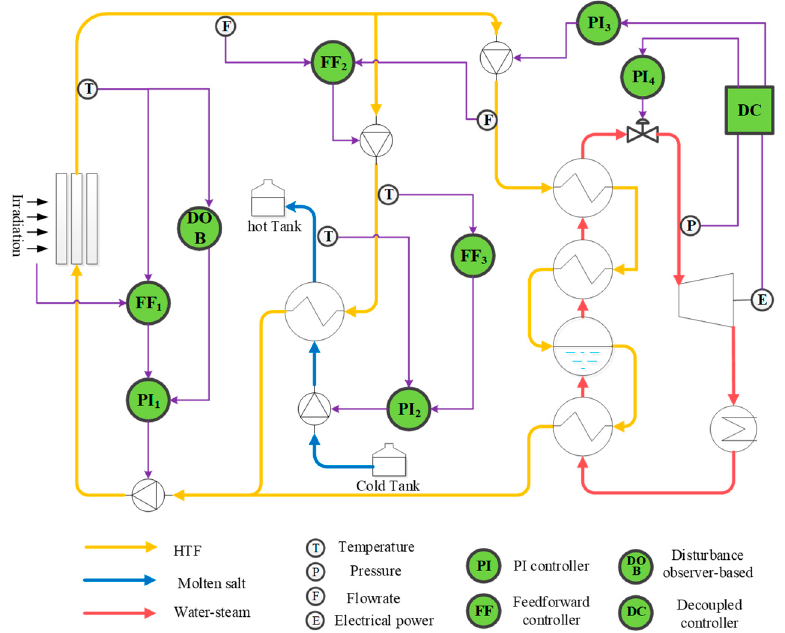
Figure 7. Schematic diagram of the coordinated control strategy for the CSP-TES system.